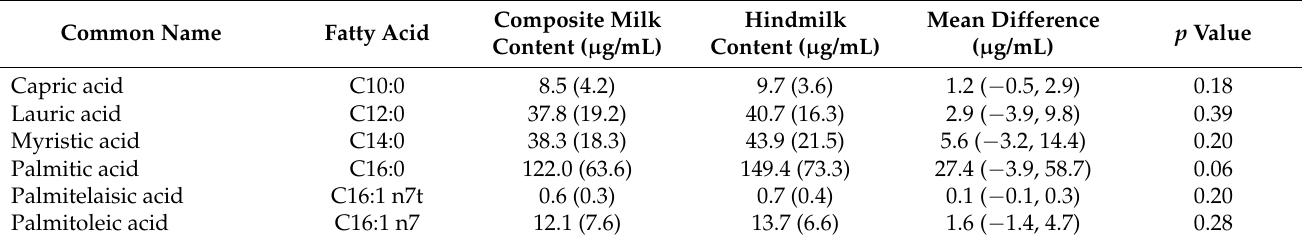
Table 4. Concentrations of milk fatty acid in composite milk and